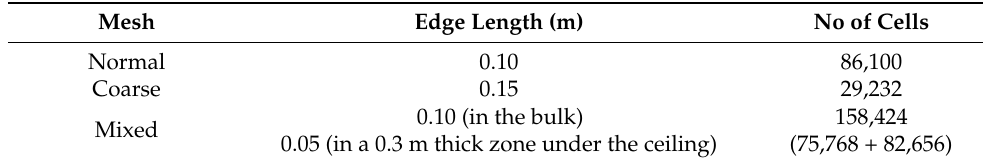
Table 6. The examined FDS